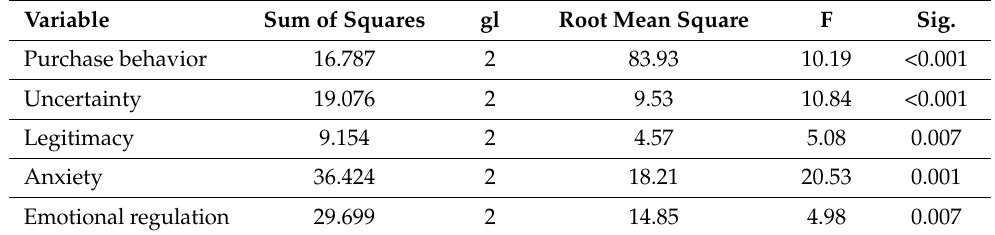
Table 3. ANOVA results: analysis of the differences by group.